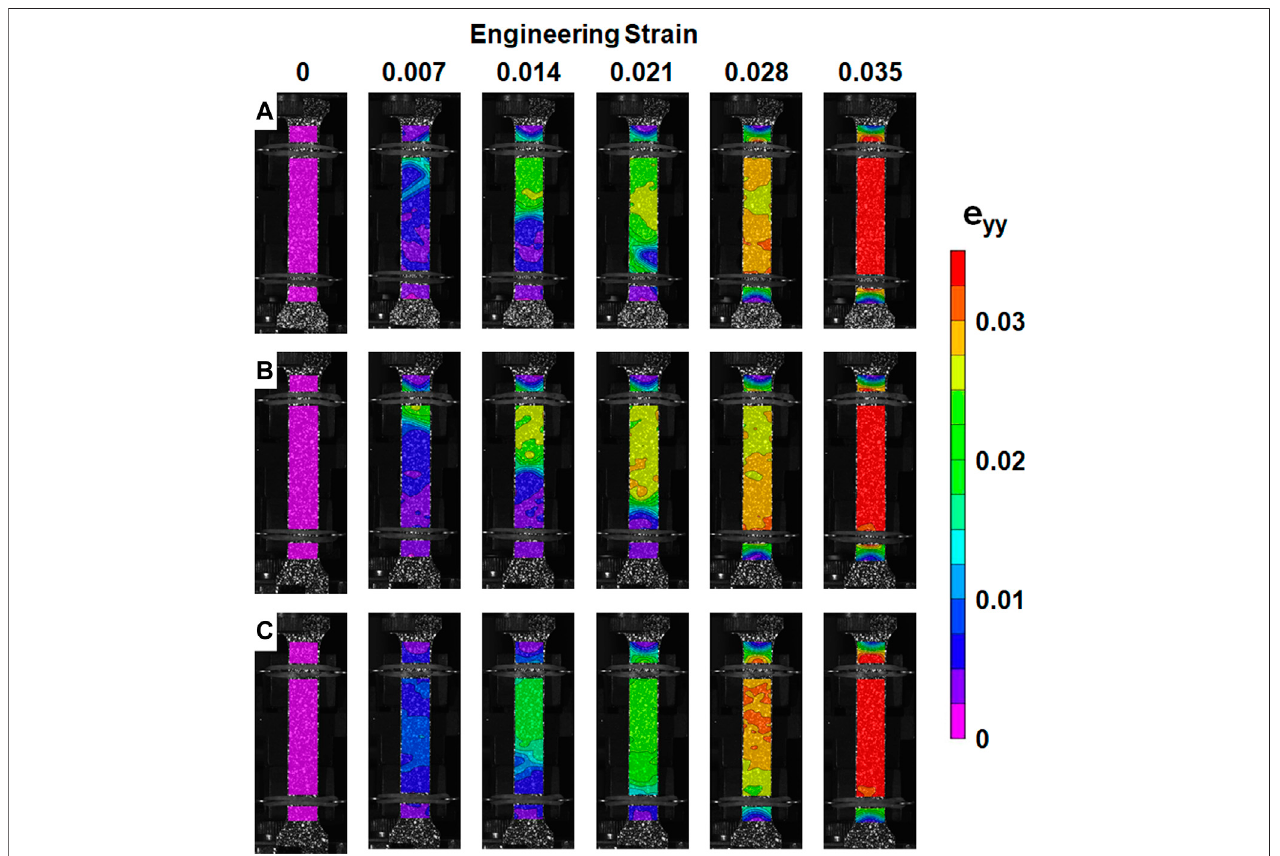
FIGURE 5 | Digital image correlation (DIC) analysis results ofthe (A) furnace cooling (FC), (B) air cooling (AC), and (C) water quenching (WQ) specimens during the initialstageoftensiledeformation(engineeringstrainfrom0to0.035).Engineeringstrainindicatestheaverageaxialstrainmeasuredbytheextensometer.Colorsindicate the longitudinal strain (e yy ) of the corresponding region.